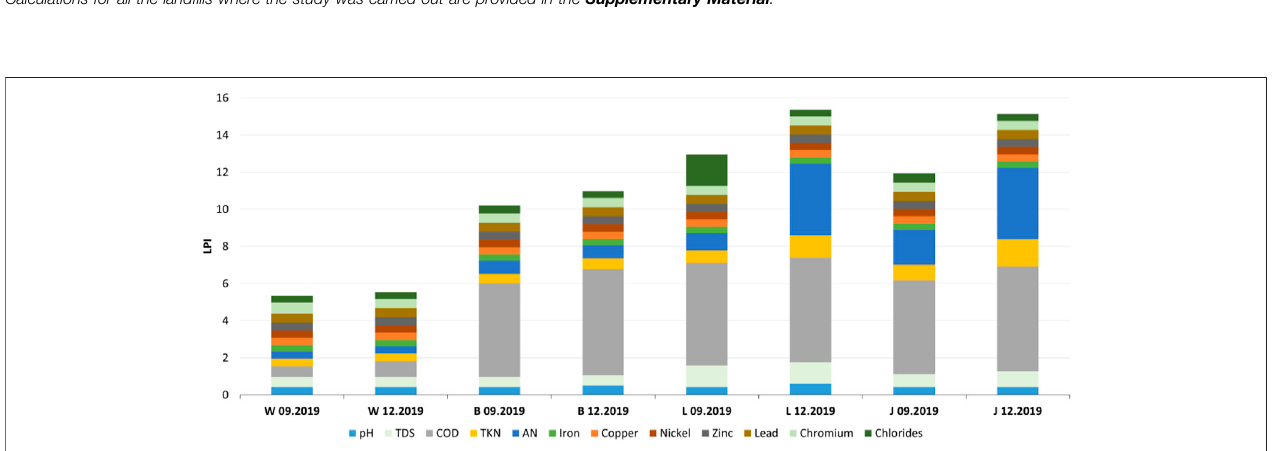
Frontiers in Environmental Science |